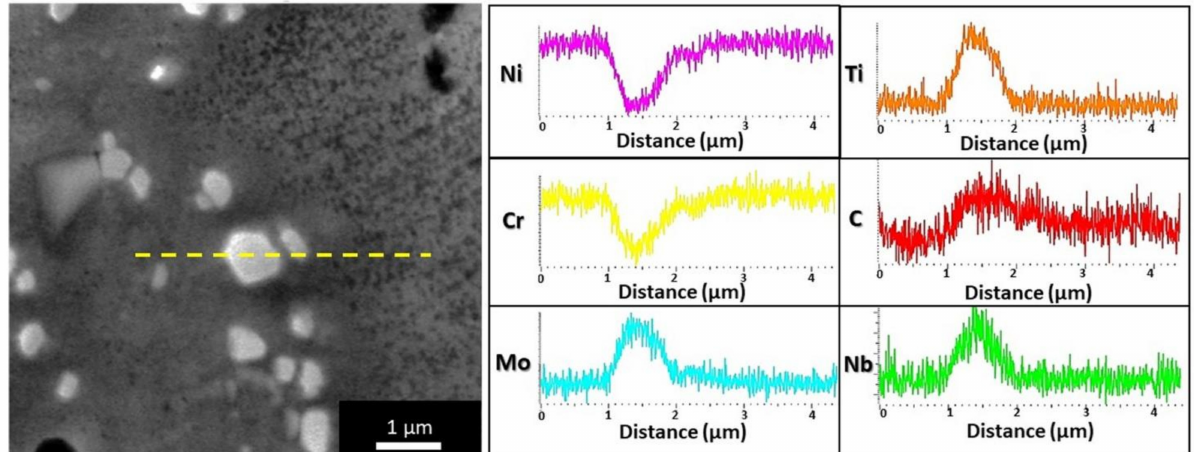
Figure 6. EDS scan line on the bright MC carbides of the SOL IN625/TiC